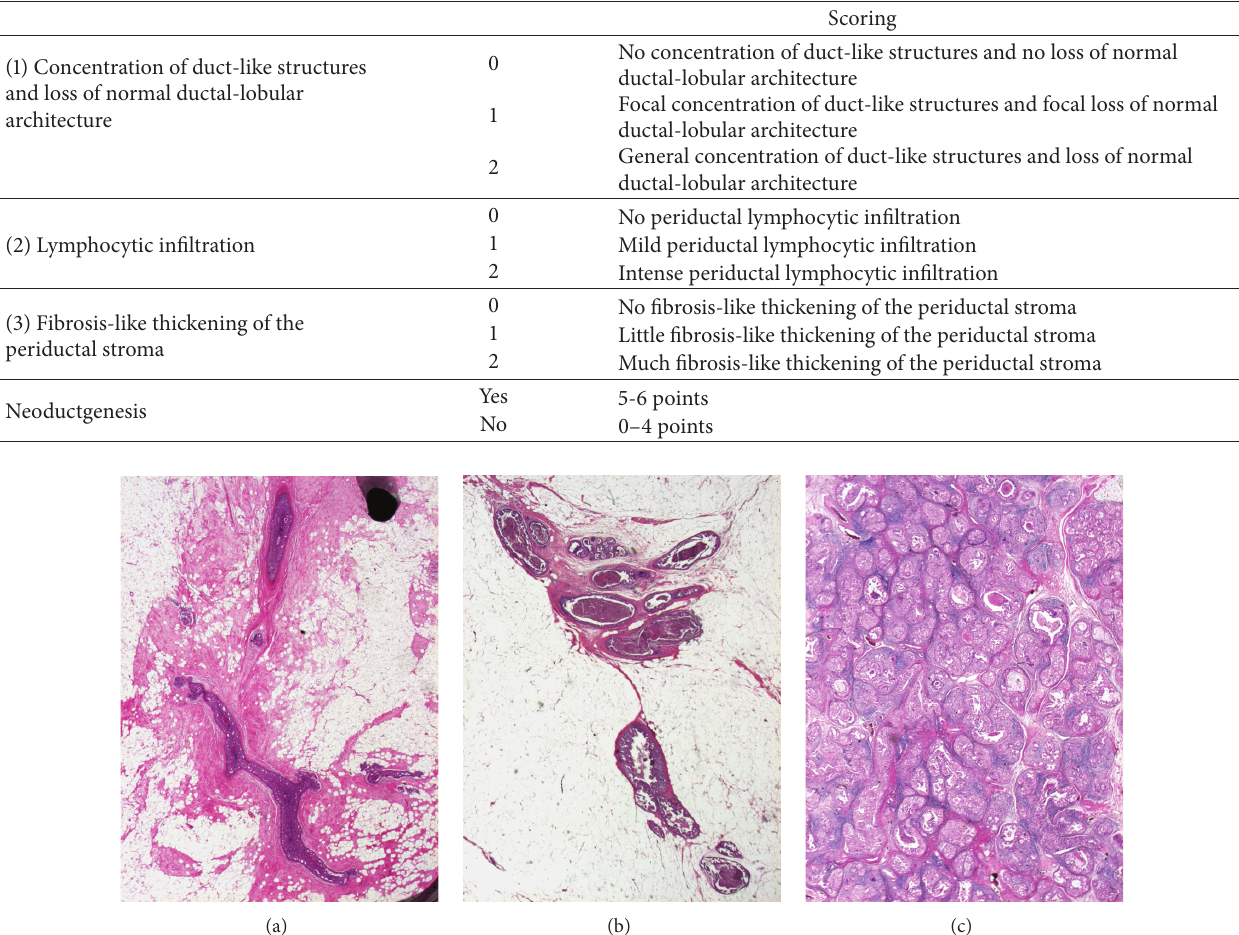
Figure 1: Concentration of duct-like structures and loss of normal ductal-lobular architecture. Hematoxylin-eosin stain; microscopic magnification 20 × . (a) No concentration of duct-like structures; (b) focal concentration; (c) general concentration and loss of normal ductal- lobular architecture.